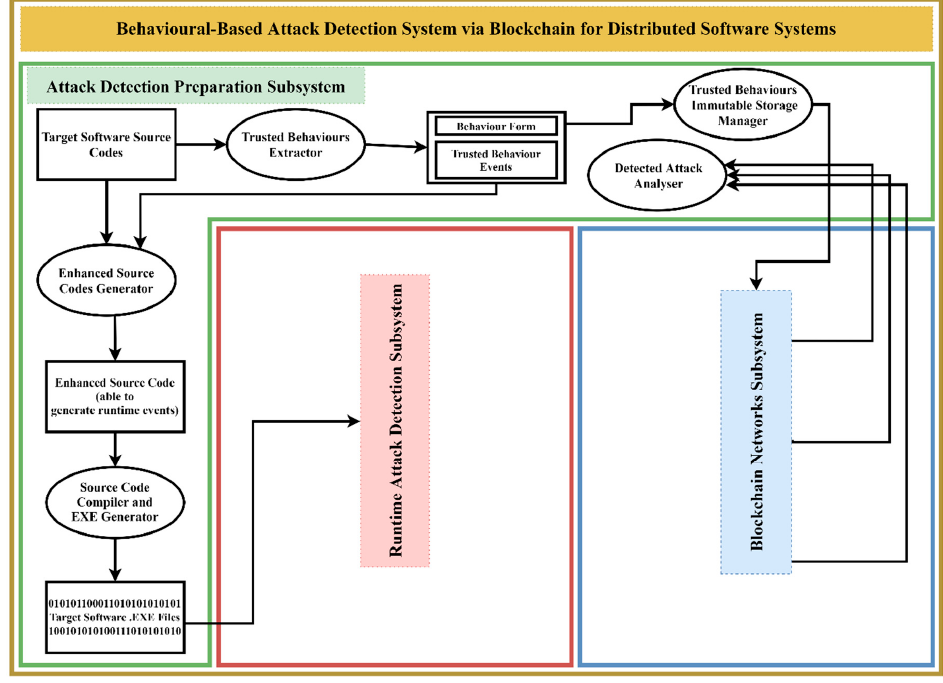
Figure 4. Software system architecture for Attack Detection Preparation (ADP) Subsystem.